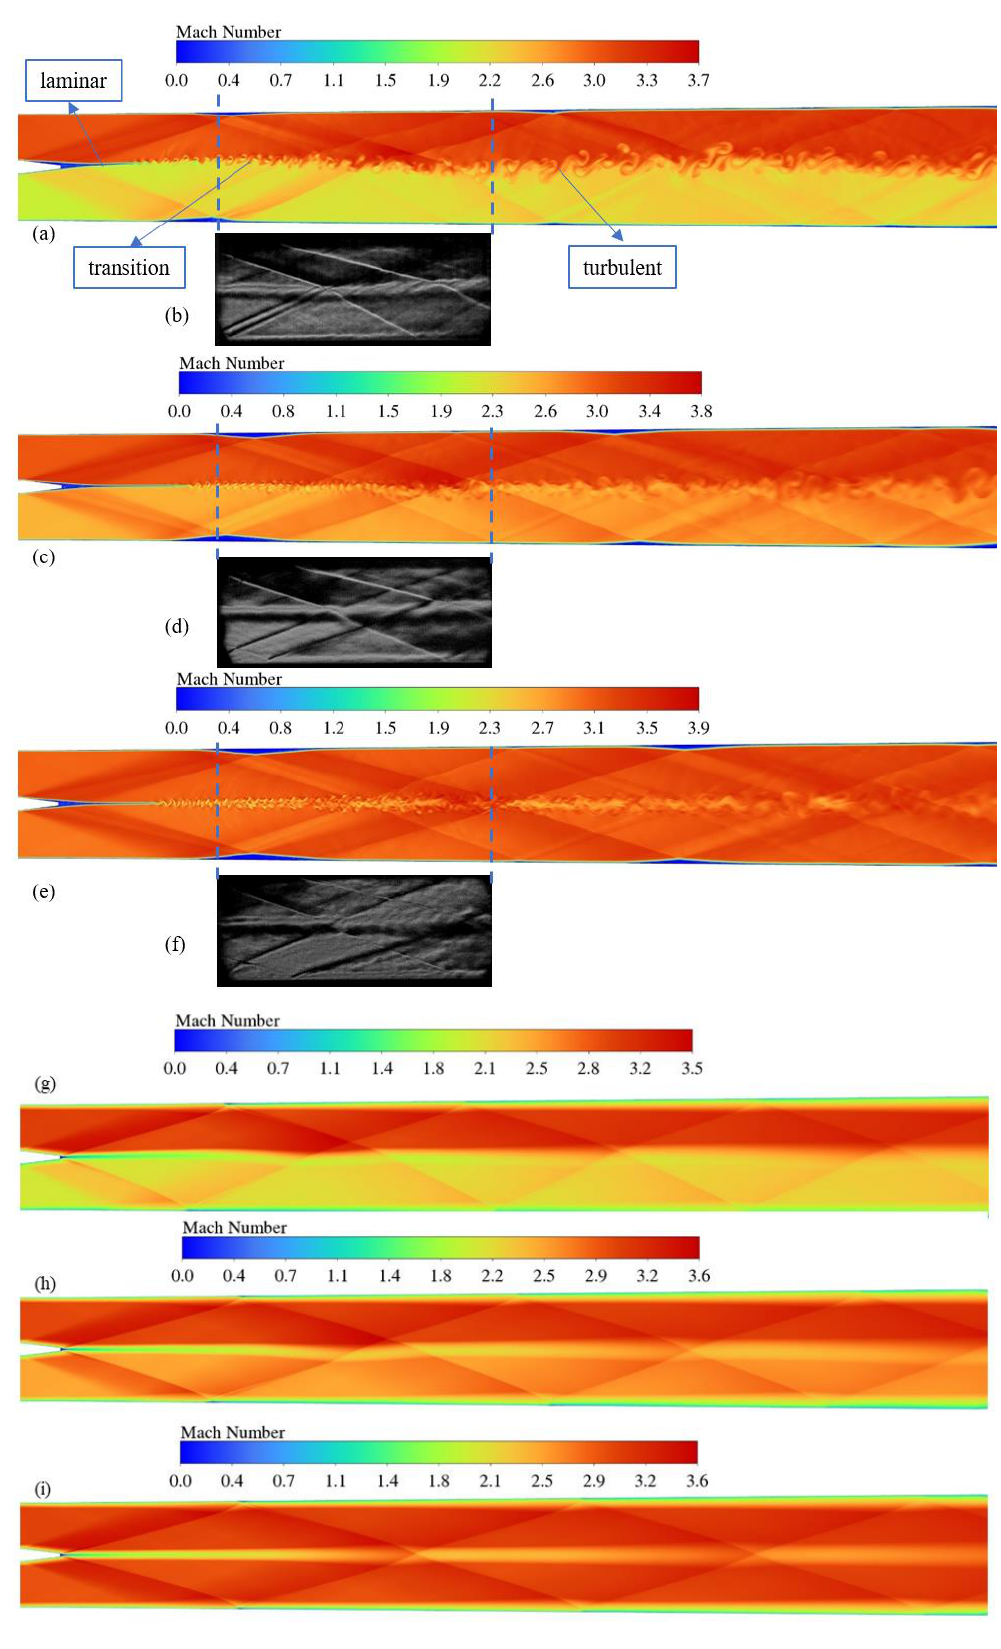
Figure 9. Ma number contours of the numerical simulation and schlieren graphs (( a , b ), case1; ( c , d ), case2; ( e , f ), case3; ( a , c , e ), LES; ( g , h , i ), RANS).